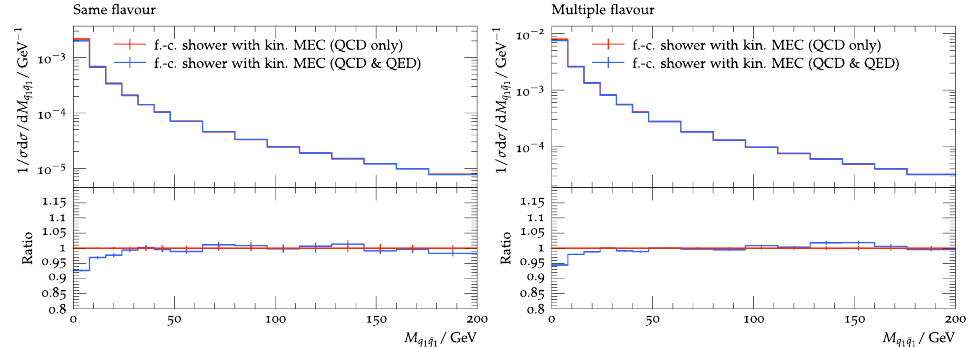
Figure 8: Both plots show the invariant mass of the pair of less energetic quark and antiquark at 1 TeV. The left plot shows e + e − → q ¯ qq ¯ q , while the right shows e + e − → q ¯ qq (cid:48) ¯ q (cid:48) . QCD / QED interference effects are only expected on the left side. However, no qualitative difference is observed between left and right, indicating that the QCD / QED interference effect in this observable is